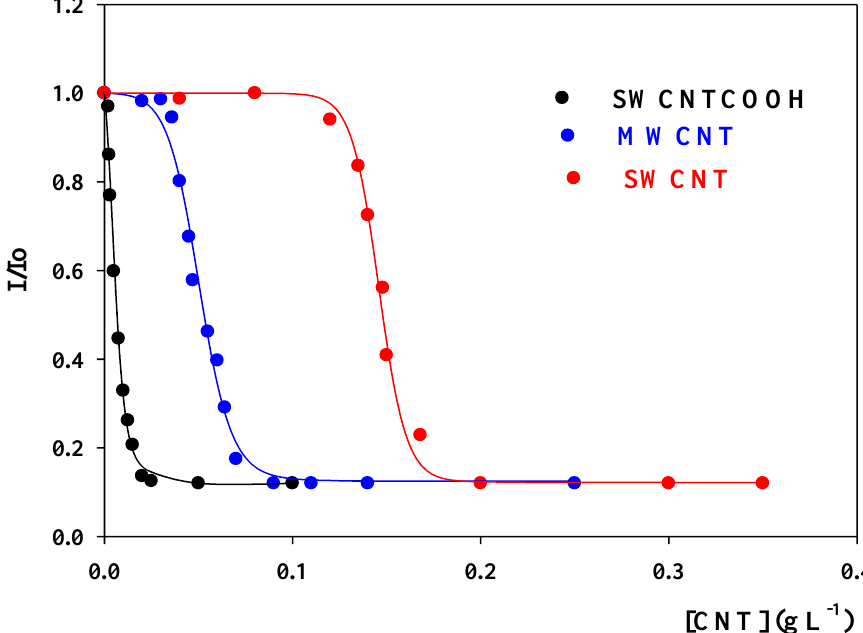
Figure 5. Dependence of I/I o ( 526 nm) on CNT concentration at pH = 7.4. Solid lines are the result of fitting the experimental data to Equations (4) and (5). T = 298.0 ± 0.1 K. Table 1. CNT concentration necessary to completely encapsulate the 7-HF at pH = 7.4. 100% 7-HF encapsulated